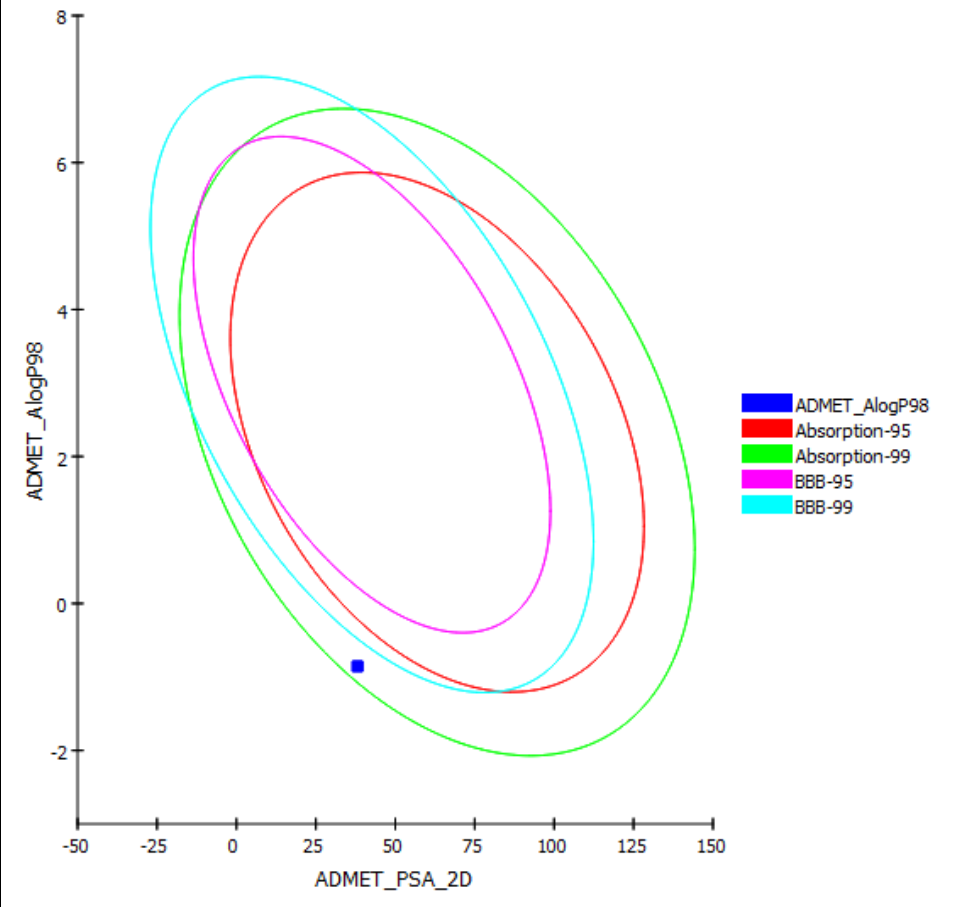
Figure 3. ADMET plot for silviridoside illustrating 95% and 99% confidence limit ellipses corresponding with the blood–brain barrier (BBB) and human intestinal absorption; %; PSA-2D: 2D polar surface area; Alog p98: atom-based log P98. Table 4. Absorption, distribution, metabolism, excretion, and toxicity (ADMET/TOPKAT) proper- ties of silviridoside